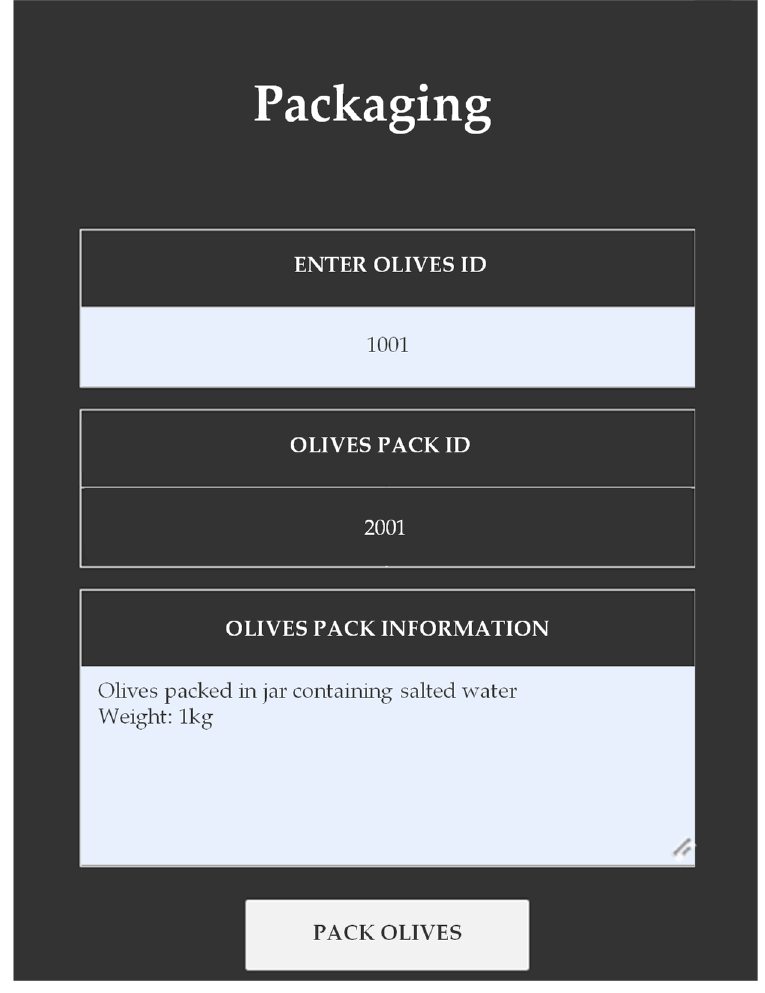
Figure 5. Packaging of Olives.